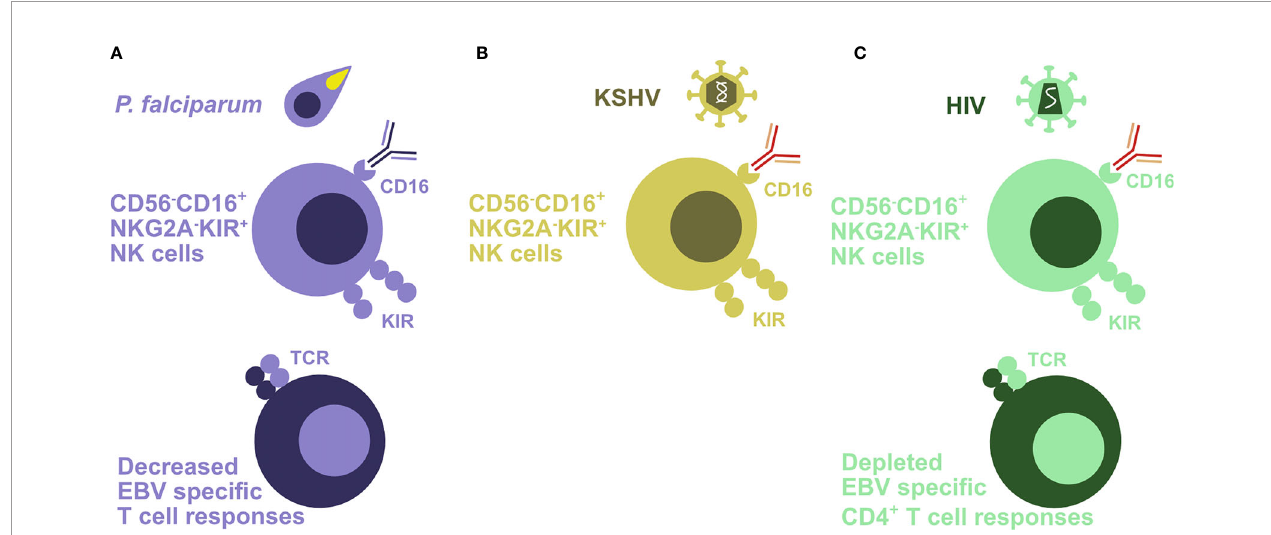
FIGURE 2 | Coinfections attenuate EBV-speci fi c immune control. (A) Holoendemic Plasmodium falciparum ( P. falciparum ) exposure and especially endemic Burkitt ’ s lymphoma are associated with an accumulation of terminally differentiated CD56 - CD16 + NKG2A - KIR + NK cells. In addition, EBV-speci fi c T cell responses are decreased in the affected patients. (B) KSHV coinfection drives CD56 - CD16 + NKG2A - KIR + NK cell differentiation in the presence of EBV infection. (C) HIV-infected patients also demonstrate an accumulation of poorly functional CD56 - CD16 + NKG2A - KIR + NK cells. In addition, this infection depletes EBV-speci fi c CD4 + T